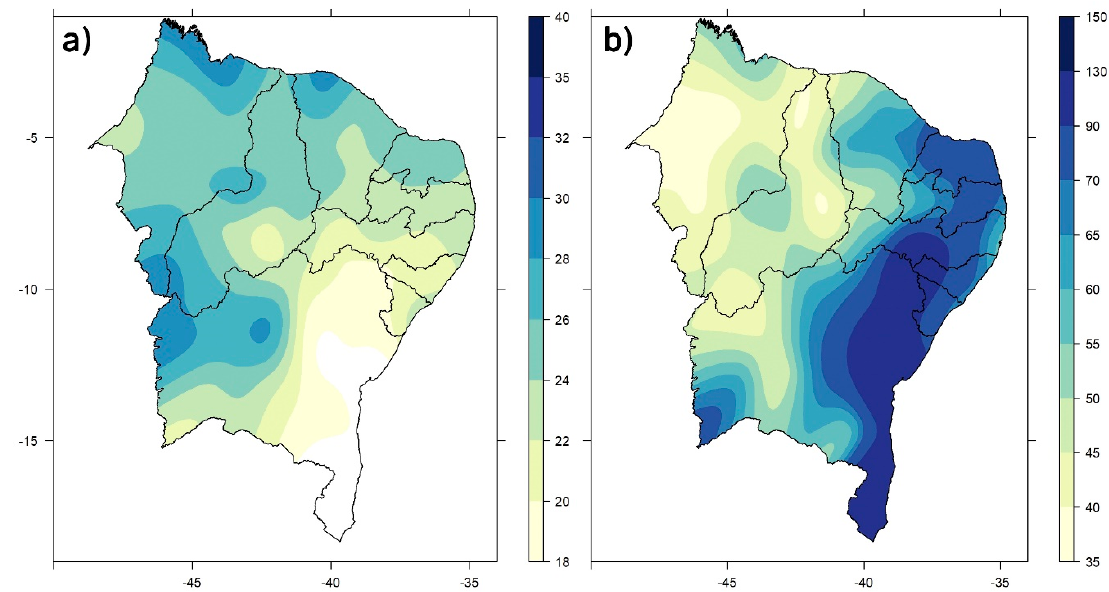
Figure 8. Return period (months) for ( a ) observed mean D and S values and ( b ) observed maximum D and S values for the period 1961 − 2017.